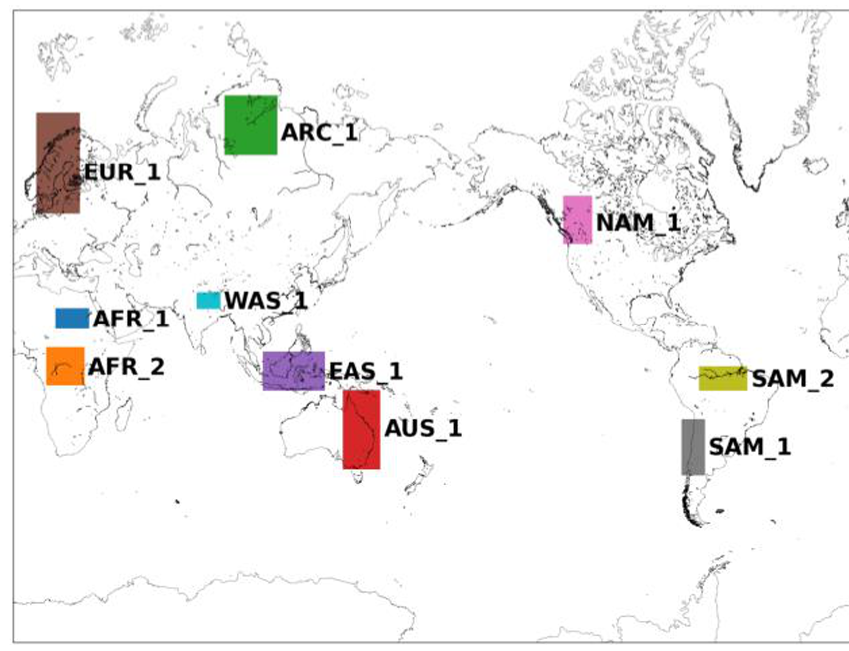
Figure 3. Evaluation domains.